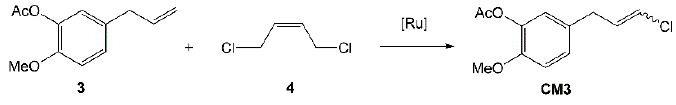
Table 3. CM of 3 with 4 in the presence of Ru1 – Ru4 and HGII 1.